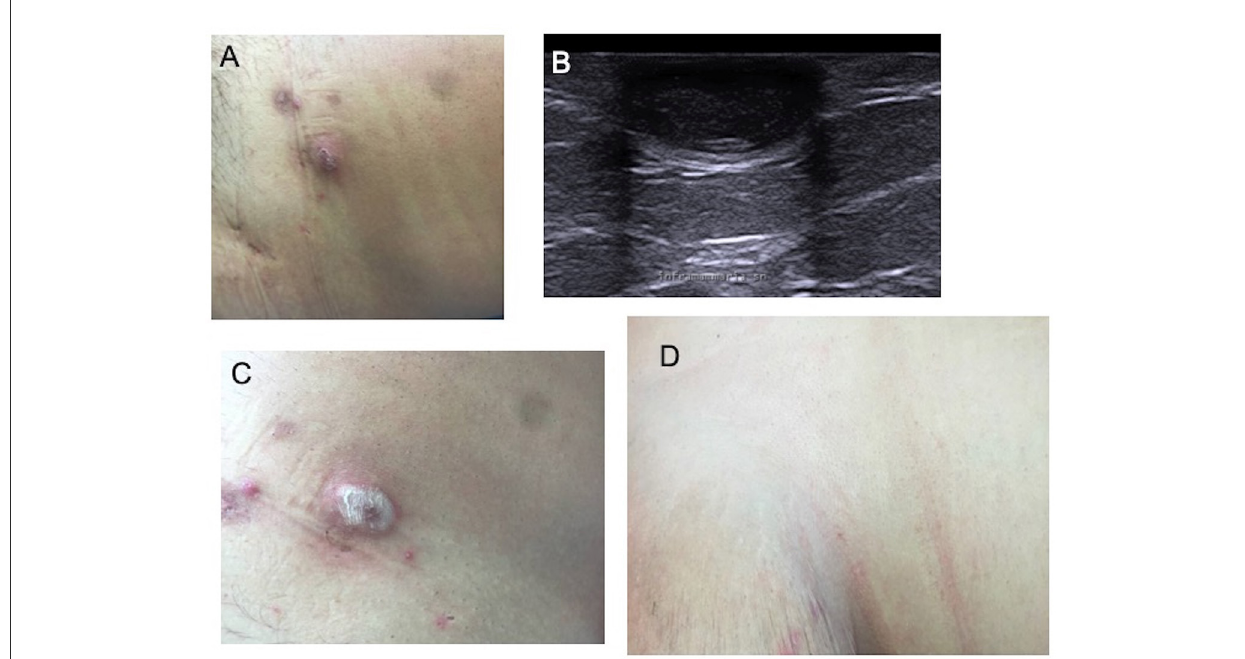
FIGURE1 Nodular lesion of hidradenitis suppurativa of the right buttocks (A) ; ultrasound imaging documenting a roundish hypoechoic nodule in the soft tissue (B) ; immediately after cryotherapy (C) ; complete resolution of the lesion at 3-month follow-up (D) .